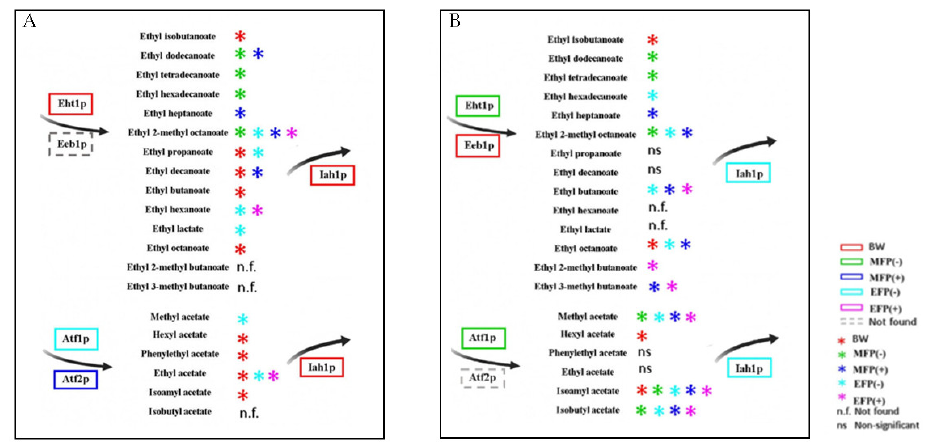
Figure 4. Summary scheme of metabolites and proteins that presented a higher concentration in each study concentration and are involved with the metabolism of esters for flor yeast ( A ) and the strain P29 ( B ). The color of the asterisks and boxes represent the condition in which the metabolites and proteins were identified, respectively. Each condition is represented by a color: red for the base wine, BW; green for the middle of the fermentation without CO 2 overpressure, MFP ( − ); dark blue for half fermentation with CO 2 overpressure, MFP ( + ); light blue final fermentation without CO 2 overpressure, EFP ( − ); pink for final fermentation with CO 2 overpressure, EFP ( + ).